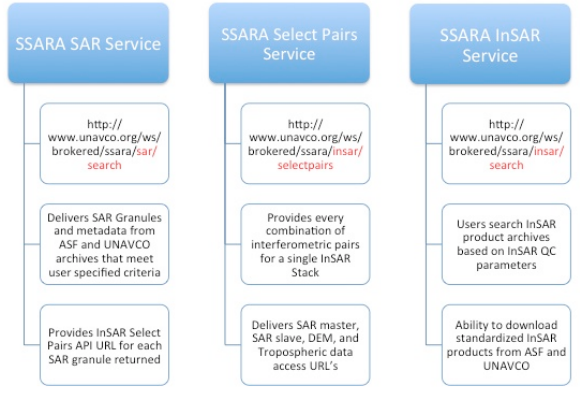
Figure 2. SSARA API Services and corresponding uniform resource locators